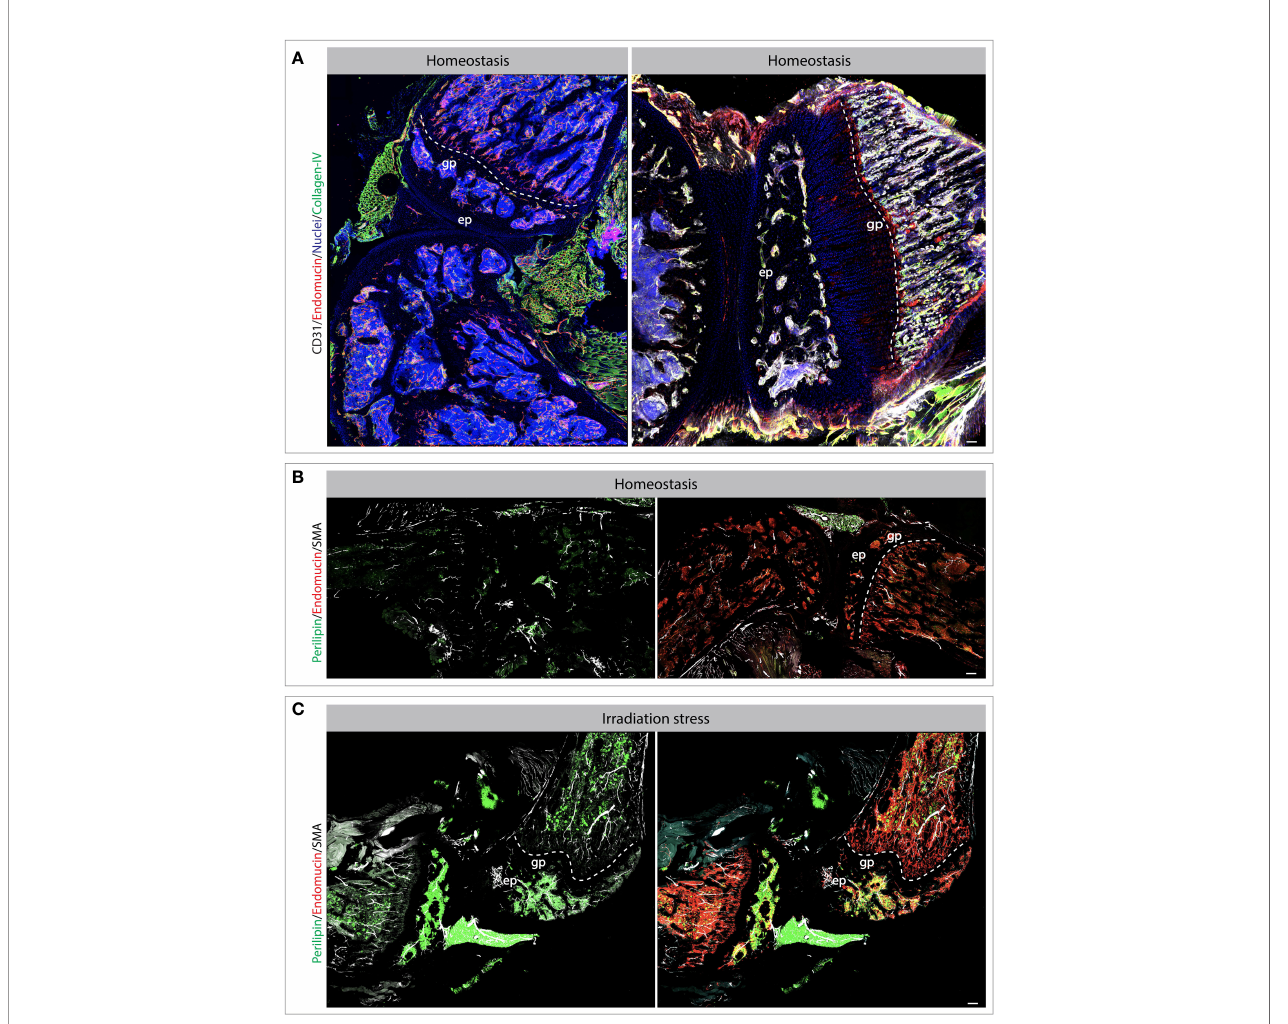
FIGURE 2 | Bone and joint vasculature and perivascular niches. Confocal images showing blood vessels and perivascular cells in bones and joints. Exemplar bones and joint sections immuno-stained for endothelial and perivascular cell markers as indicated on the images (A – C) . The changes and vascular cells and perivascular microenvironments can be observed during stress conditions such as radiation-induced injury. Speci fi cally, the tile view imaged demonstrate the changes in vascular morphology and accumulation of adipocytes post radiation (B, C) . Scale bar represents 200 m m. gp, growth plate; ep,